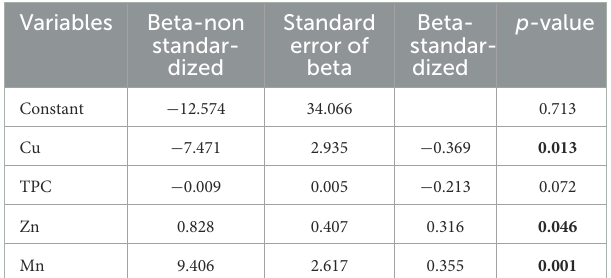
TABLE 3 Regression model for the association between trace elements, total phenolics and ABTS based on multivariable linear regression modeling.